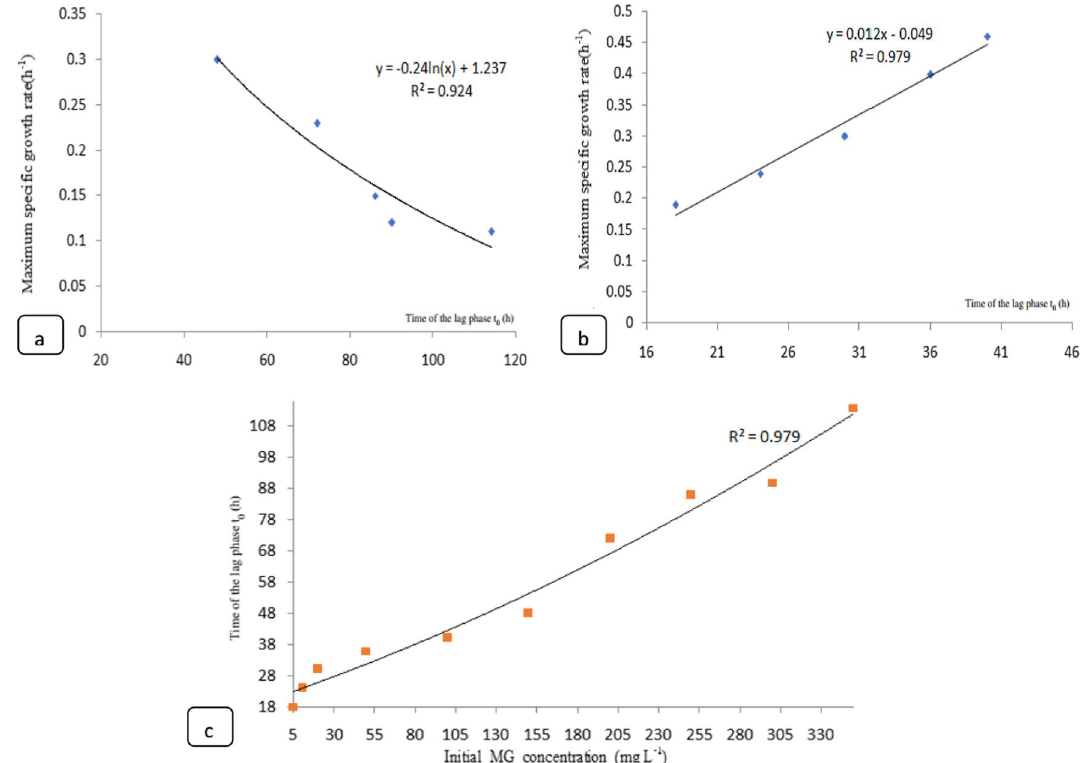
Fig. 22 Time of the lag phase ( t 0 ) versus the initial MG concentration ( a ), and ( S 0 ) Maximum specific growth rate μm versus the time of the lag phase t 0 for S 0 below ( b ), above ( c ) MG concentration mg L −